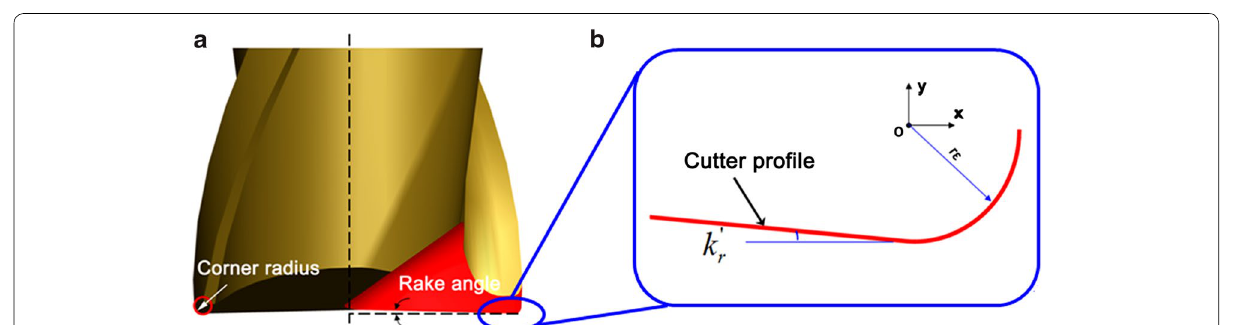
Figure 1 Flow chart of proposed surface generation process